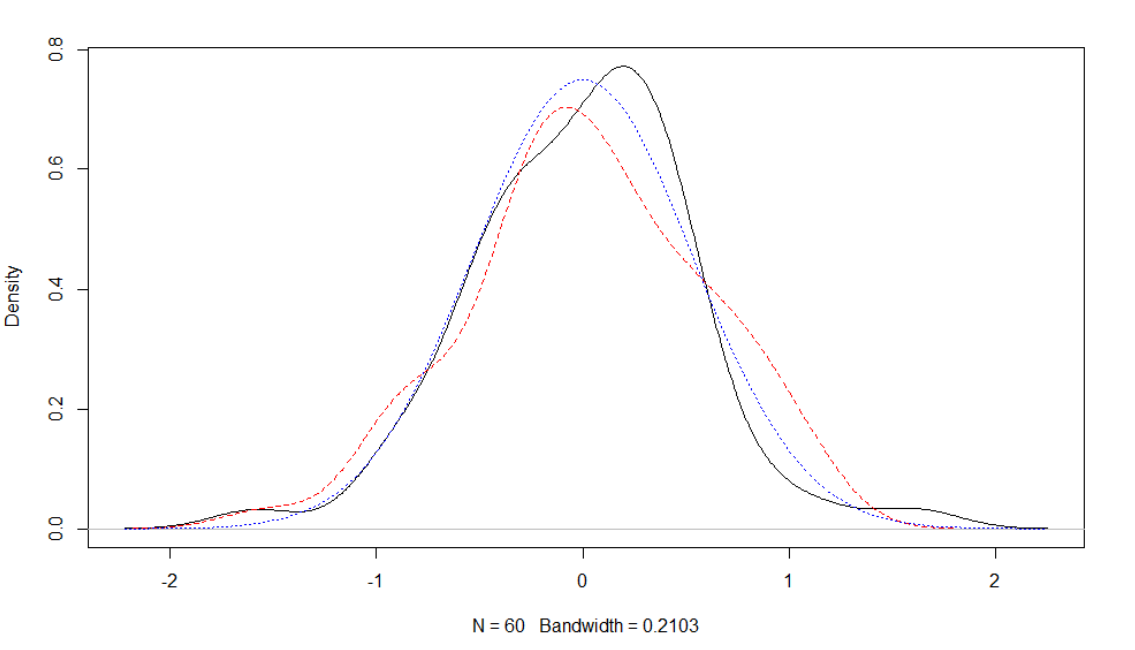
Figure 2: Assessing model assumptions with graphical methods of base R. Density of the residuals of a fitted model based on normal distributed values (black solid line). Density of values from a normal distribution with number and standard deviation identical to the residuals of the fitted model (red dashed line). Normal distribution with standard deviation identical to the residuals of the fitted model (blue dotted